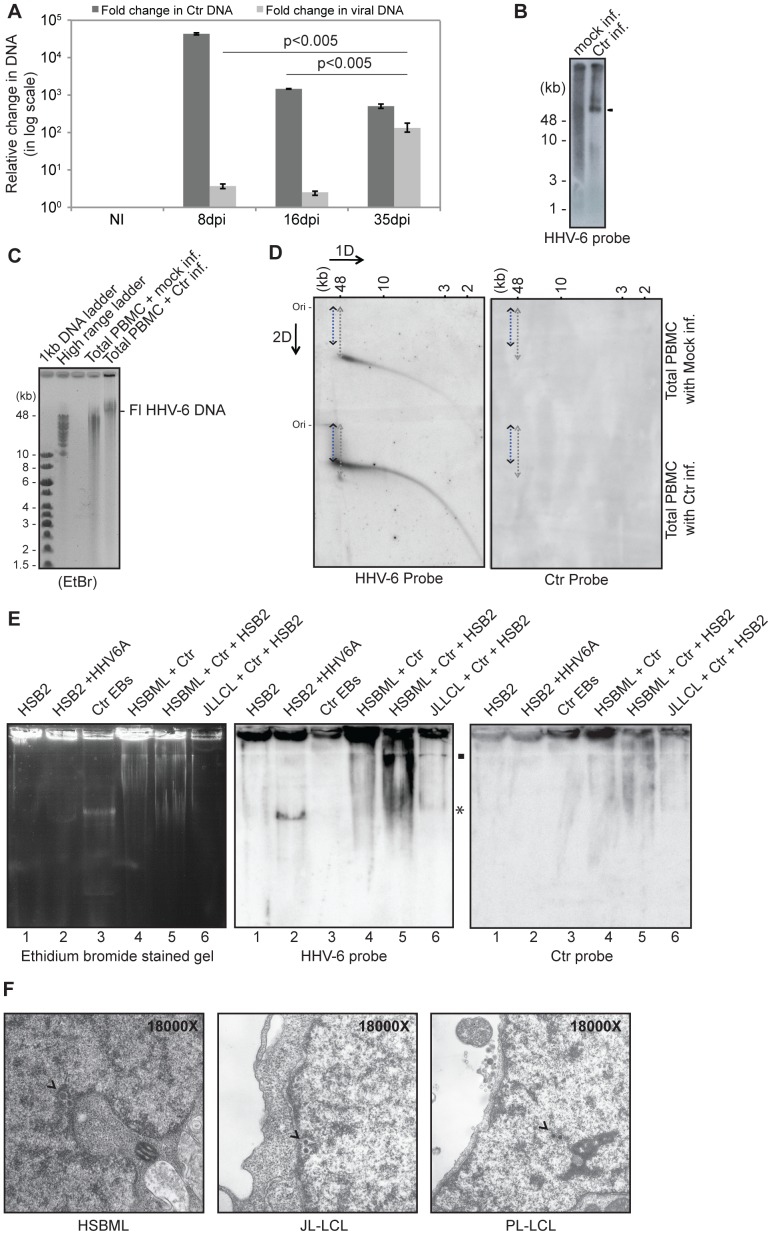

C. trachomatis infection induces formation of extra-chromosomal HHV-6 DNA in CiHHV-6 cell lines and patient blood samples.(A) C. trachomatis infection induces viral DNA replication in HSB-ML cells. HSB-ML cells were infected with C. trachomatis at an MOI of 2 for 2 days after which cells were washed thoroughly and grown in presence of fresh media with 1 µg/ml of doxycycline for 35 days. Total DNA was isolated at 3 different time intervals and used for qPCR assay. Data represent the mean ± SEM of 3 independent experiments. (B) Southern hybridization of C. trachomatis-infected HSB-ML cells shows detectable amount of extra-chromosomal HHV-6 after 35 days of infection. Total DNA from non-infected (NI) and 35 days post infected (dpi) HSB-ML cells were run on 1% agarose gel and were subsequently used for southern transfer and hybridization. HHV-6 specific band is marked by dark arrowhead. (C) Ethidium bromide (EtBr) stained agarose gel showing full-length HHV-6 DNA in total PBMCs of a CiHHV-6 individual after 16 days of Chlamydia treatment. Fl, full-length. (D) Same gel as in (C) was processed for neutral-neutral 2D DNA electrophoresis and subsequent hybridization with a HHV6 probe and then with C. trachomatis probe. Migration rate of full-length HHV-6 DNA from C. trachomatis-infected cells is different from that of mock infected cells. Ori, the position of the origin of the second-dimension gel electrophoresis. The positions of the size markers for the first-dimension gel electrophoresis are shown at the top. (E) Gardella gel analysis and subsequent southern hybridization showing extra-chromosomal HHV-6 DNA after C. trachomatis infection. HSB-ML and JL-LCL cells were infected with C. trachomatis (MOI 5) for 2 days after which cells were washed thoroughly and grown in presence of fresh media with 1 µg/ml of doxycycline for another 7 days. Fresh HSB-2 cells were added to these cells and were co-cultured for another 2 weeks. 2.5×106 of these cells were loaded directly onto a Gardella gel and subsequently stained with ethidium bromide and afterwards transferred to a nylon membrane. HSB-2, HHV-6-infected HSB-2 for productive virus infection (HSB-2+HHV-6), C. trachomatis elementary bodies (Ctr EB) and C. trachomatis-infected HSB-ML cells, which were subsequently not co-cultured with HSB-2 cells (HSB-ML+Ctr) were loaded as controls. Nylon membrane was hybridized first with a HHV-6-specific probe and subsequently stripped and used again for hybridization with C. trachomatis-specific probe. Extra-chromosomal linear HHV-6 DNA is marked with *and possible nicked circular viral DNA is marked with a rectangle. Chlamydial DNA did not run in the gel due to the size of genomic DNA and hence C. trachomatis-specific hybridization was observed only in the wells of lane 4 and 5. A clear band (probably the chlamydial plasmid) in lane 3, which was observed after ethidium bromide staining was not detected by C. trachomatis-specific probe. Instead some additional bands were detected in lane 4 with C. trachomatis-specific probes. (F) Transmission electron microscopy pictures showing appearance of particle like condensed DNA structures (marked by black arrowhead) in CiHHV-6 cell nuclei after Chlamydia infection.